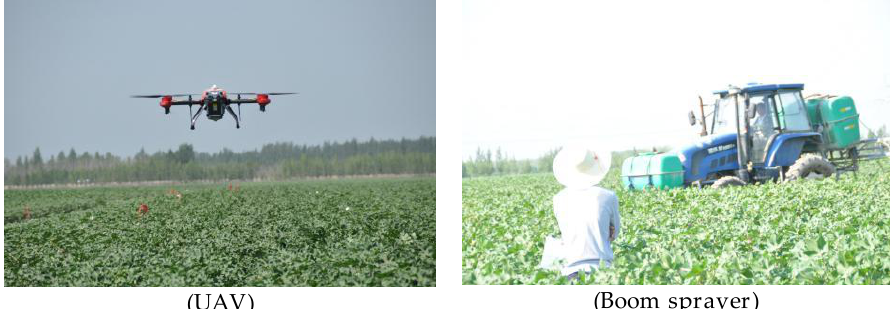
Figure 1. Unmanned aerial vehicle (UAV) sprayer and boom sprayer.